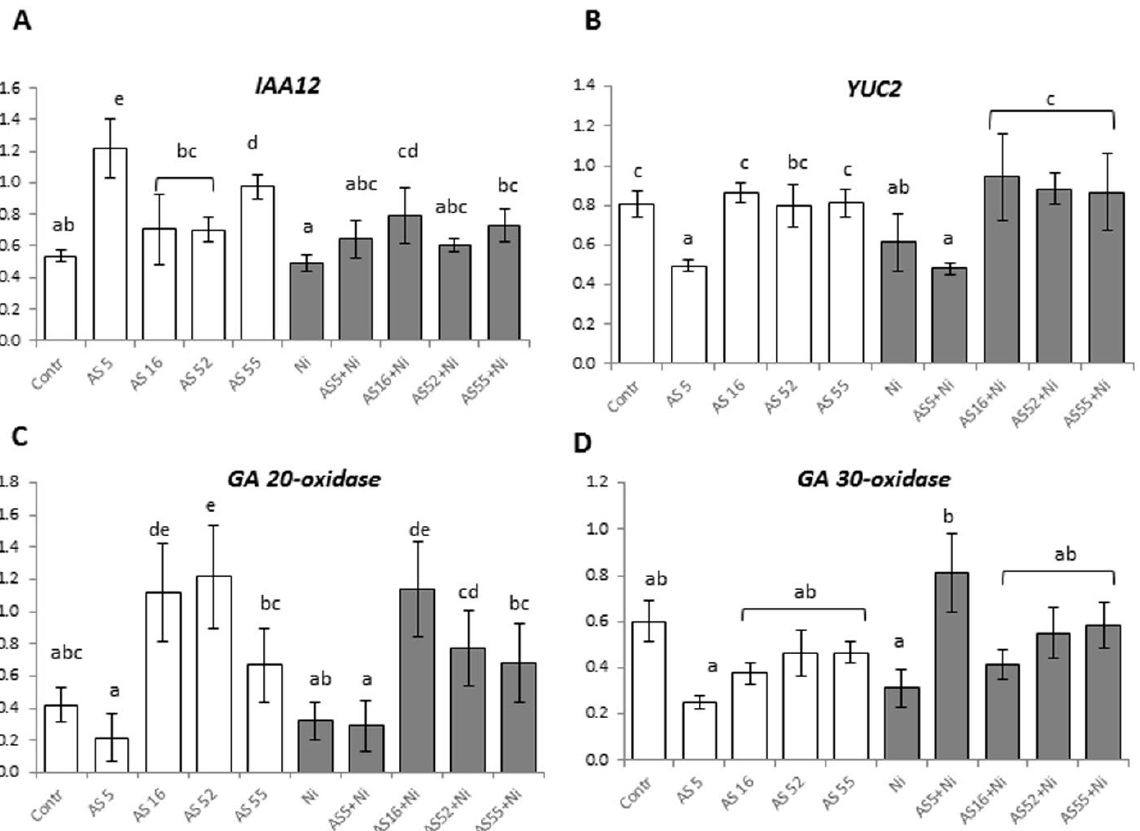
Figure 4. Comparison of real-time RT-PCR expression levels of the genes involved in auxin signaling (IAA12) ( A ) and biosynthesis (YUC2) ( B ), and gibberellin GA 20-oxidase ( C ) and GA 30-oxidase ( D ) biosynthesis. Each column represents the expression level (mean and SD) for each gene in each group. Plants non- exposed (bars in white) and exposed to 200 µM Ni (bars in grey) for 4 weeks. Different letters indicate a statistically significant difference among treatments in ANOVA comparisons and the post-hoc Tukey HSD at the level p = 0.05. Error bars represent ± SD.